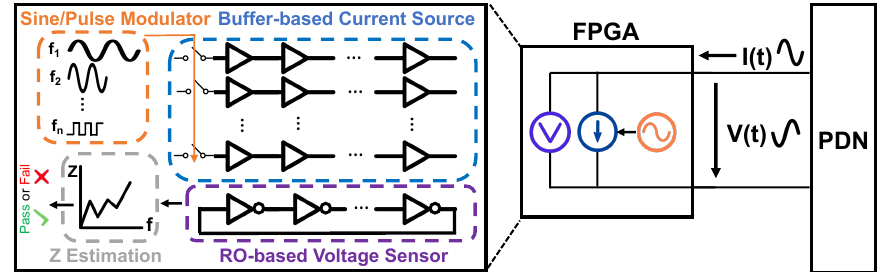
Figure 3: Main building blocks of an embedded VNA on